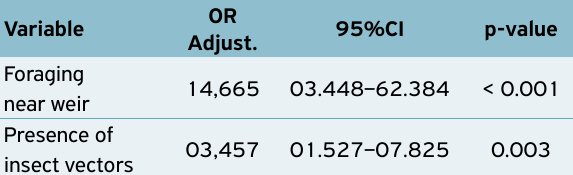
Table 2. Variables that remained in the final multivariate analysis model for T. vivax trypanosomiasis in cattle in the Mossoró/RN microregion,